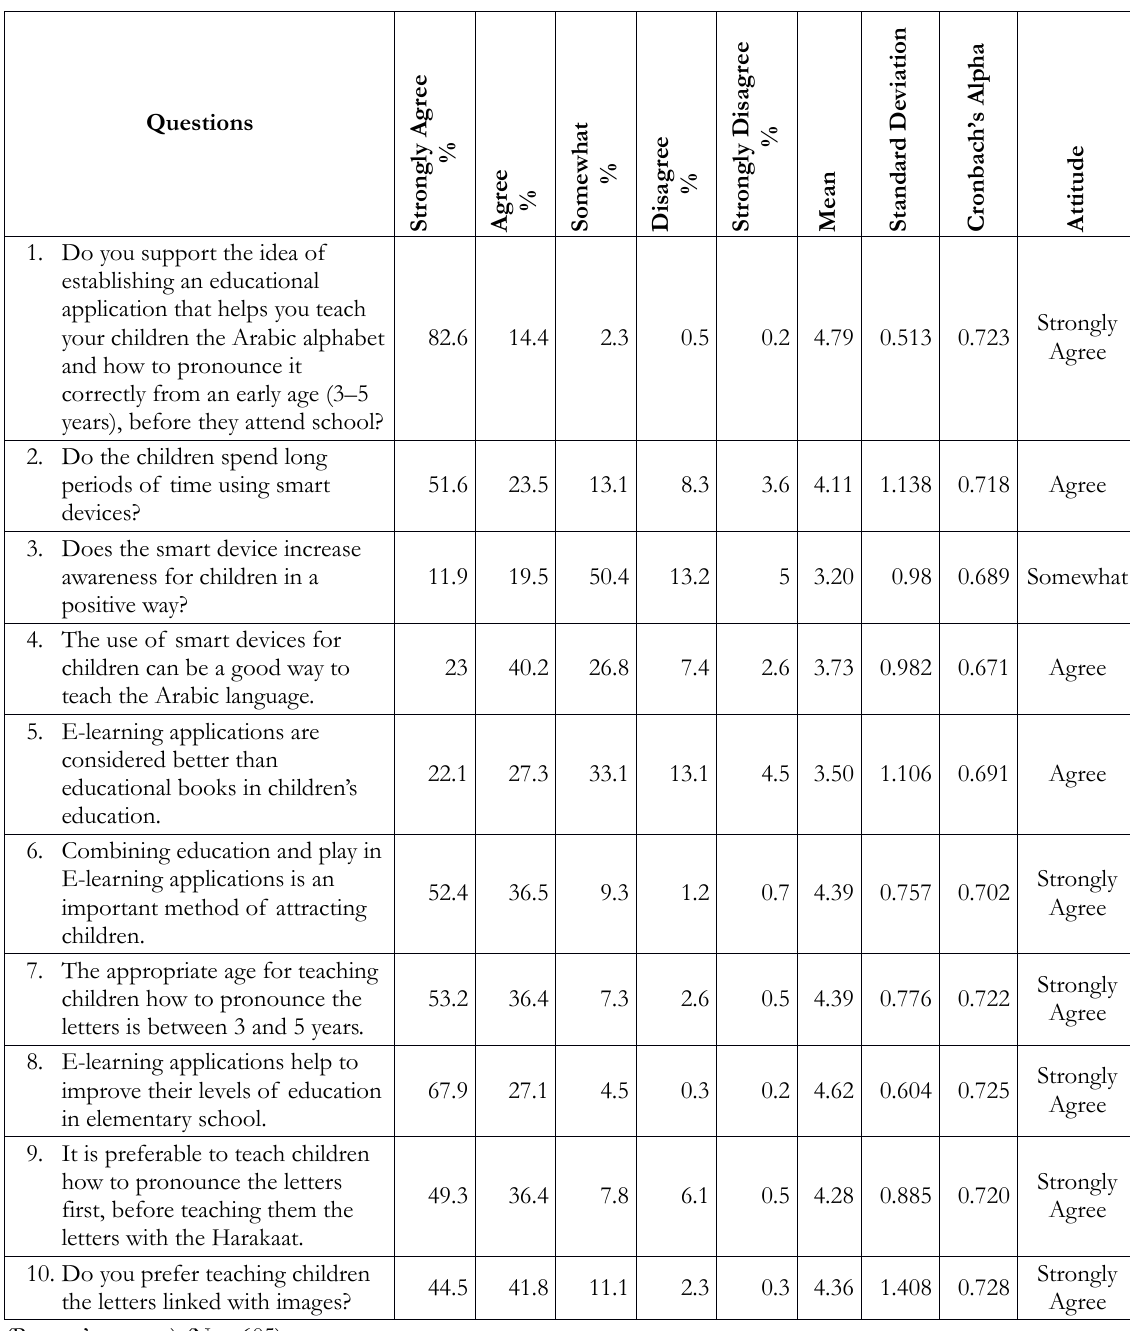
Table 2. Ranking Analysis of the Likert-Type Scale and Reliability